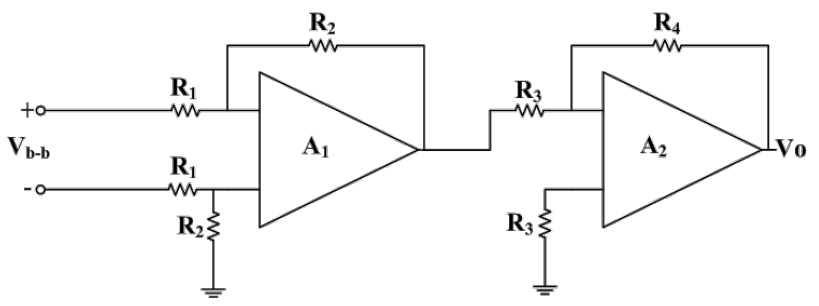
Figure 6. Readout circuit for the magnetic microsensor.